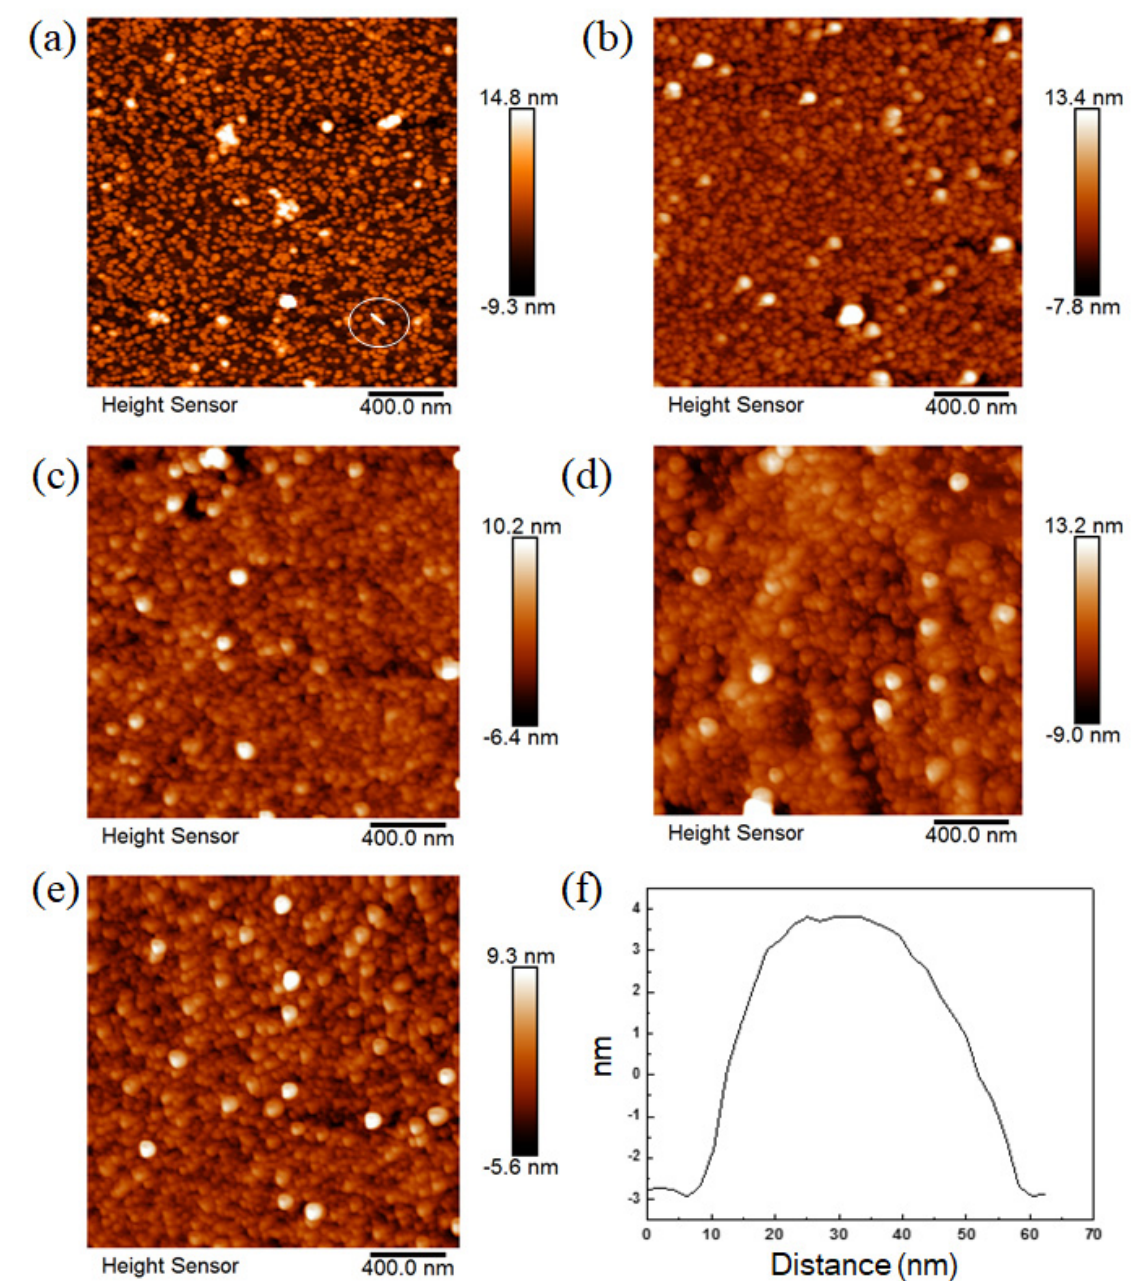
Figure 2. Ferritin layers deposited on a substrate using layer-by-layer deposition. ( a ) One layer; ( b ) two layers; ( c ) three layers; ( d ) four layers; ( e ) five layers; ( f ) line profile of the ferritin as shown in ( a ) indicated in the circle.